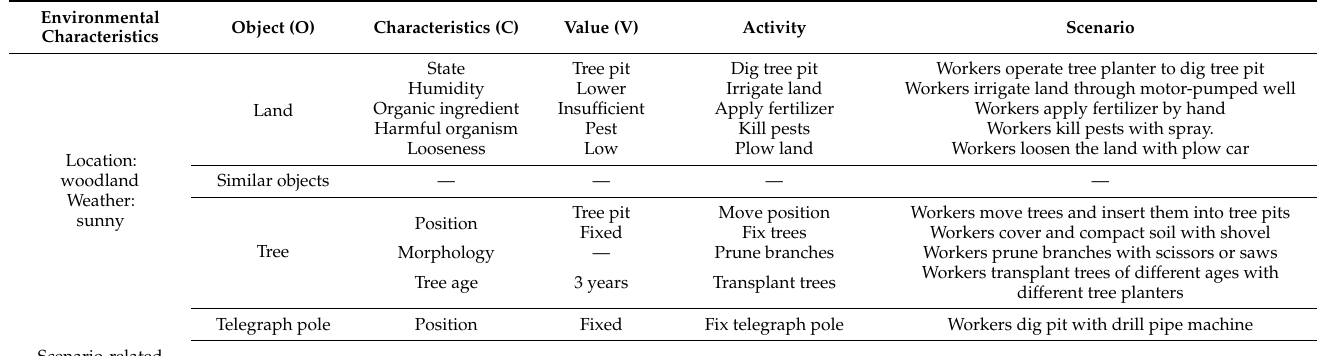
Table 3. Scenario-related product-acquisition process based on extending the action object.